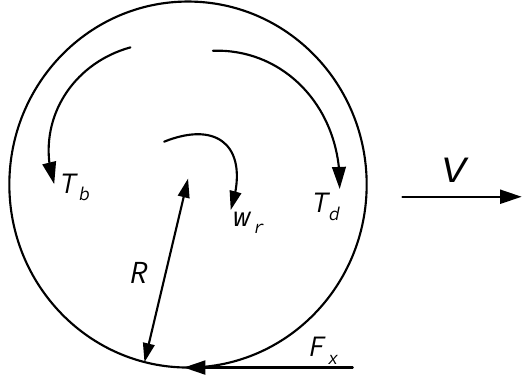
Figure 3. Principle diagram of wheel rotation dynamics.